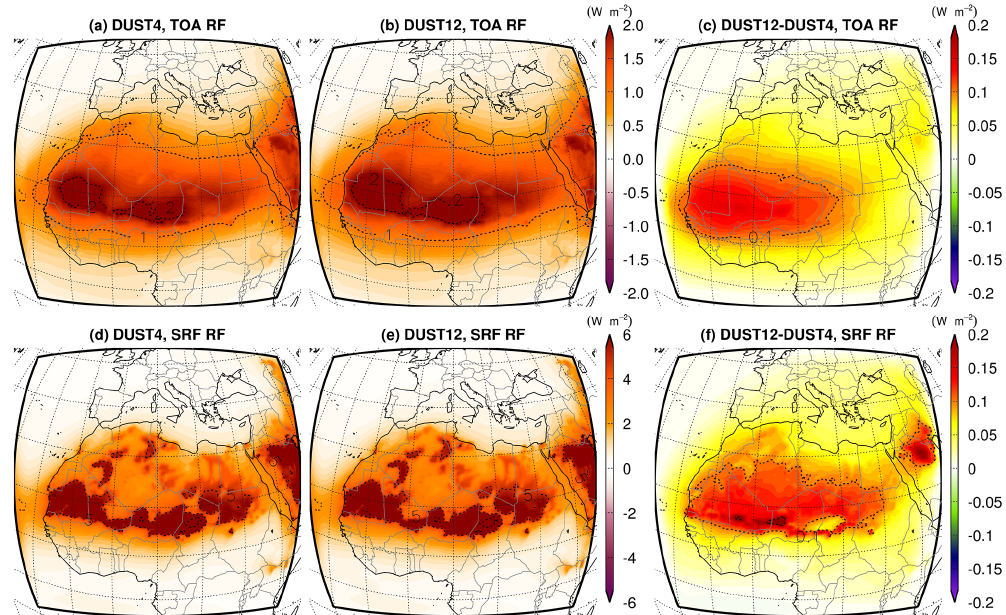
Figure 14. Top-of-the-atmosphere (top) and surface (bottom) radiative forcing in the longwave spectrum for the period December 2006 to November